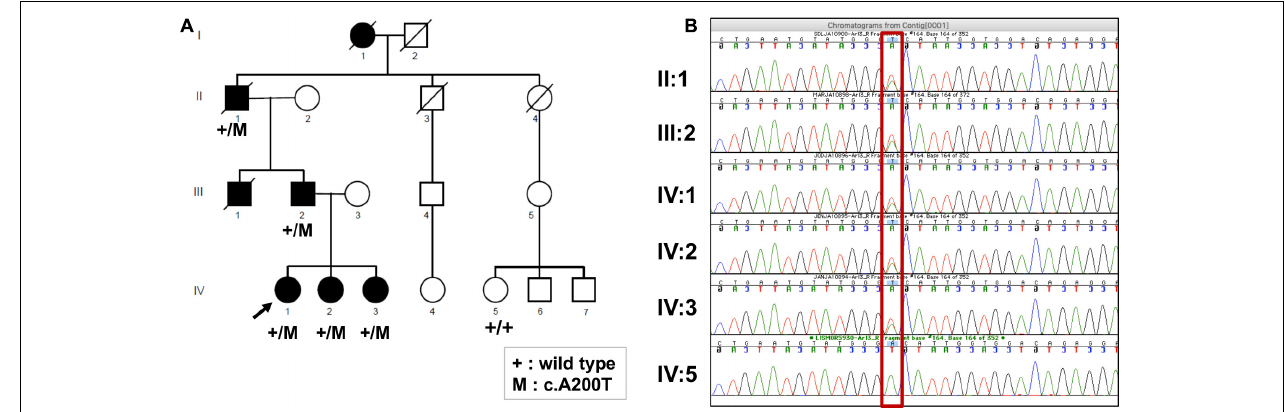
FIGURE 2 | (A) Pedigree of the family, showing members affected and unaffected by the IRD. The segregation of the ARL3 variant c.A200T is shown where mutation is indicated by “+/M,” and its absence is indicated by “+/+.” (B) Sanger sequencing electropherogram of the available family members confirming the exome sequencing results, as all affected are heterozygous (A/T) and the unaffected is homozygous for the wild-type allele (A/A) (shown in red